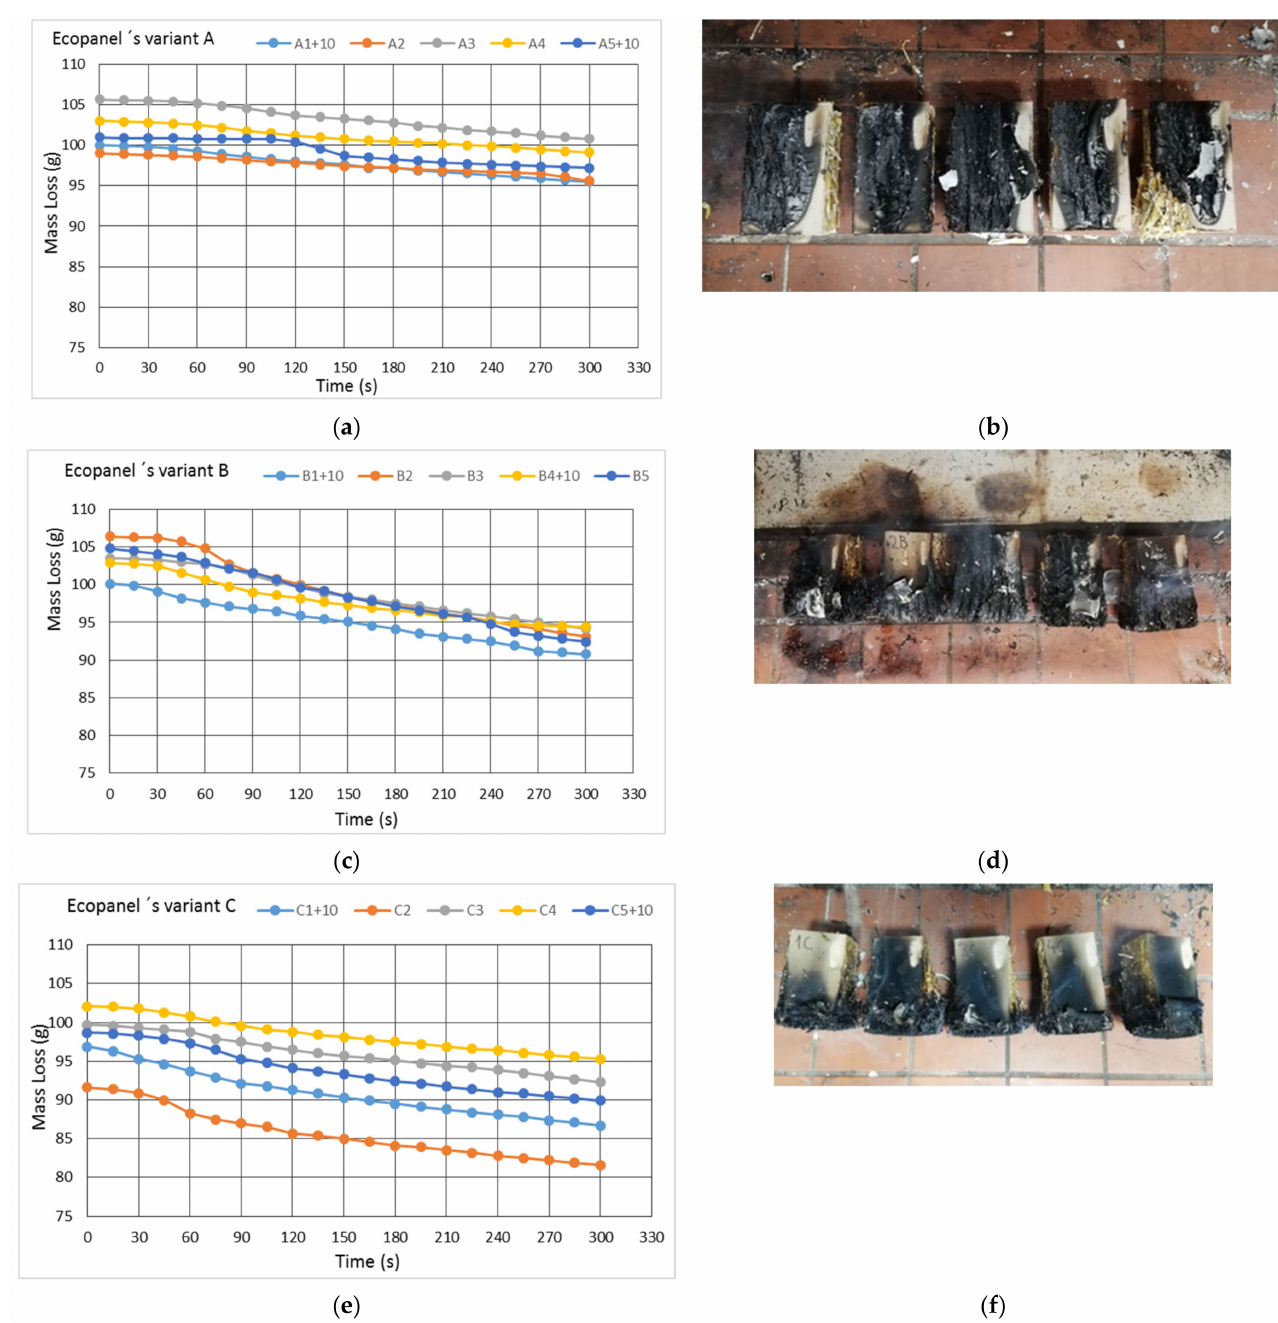
Figure 5. Graphical dependences of mass loss during experiment of ( a ) Group A samples, ( c ) Group B samples, ( e ) Group C samples. Samples after the experiment ( b ) Group A samples, ( d ) Group B sample, ( f ) Group D samples. Exposure time was 5